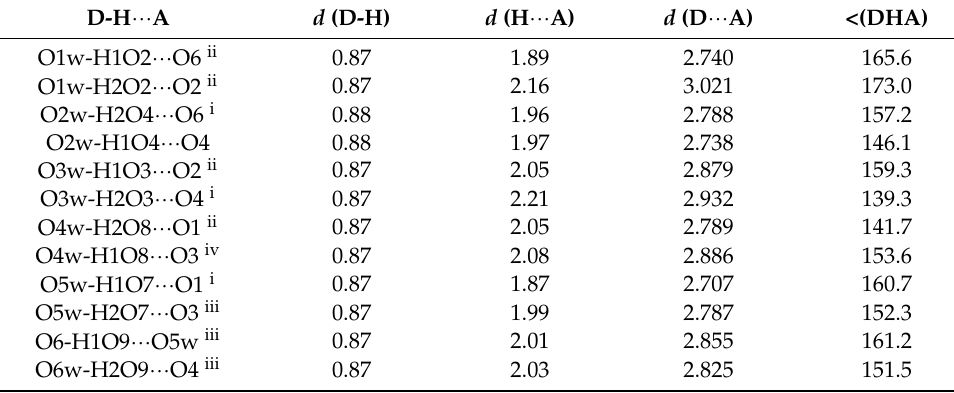
Table 7. Hydrogen bond interactions [Å, ◦ ] in 5